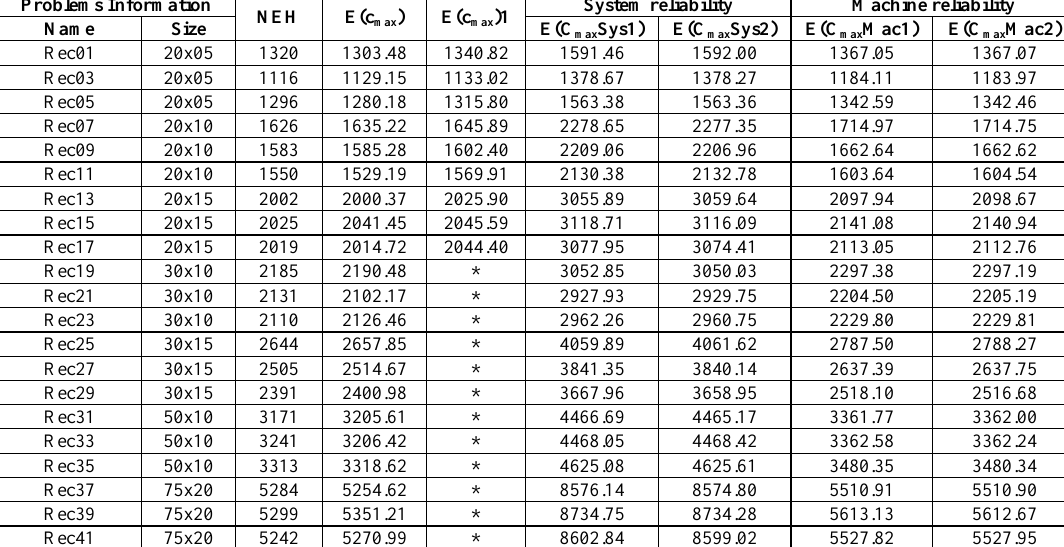
Table 3. Computational results for rec problems normally distributed.